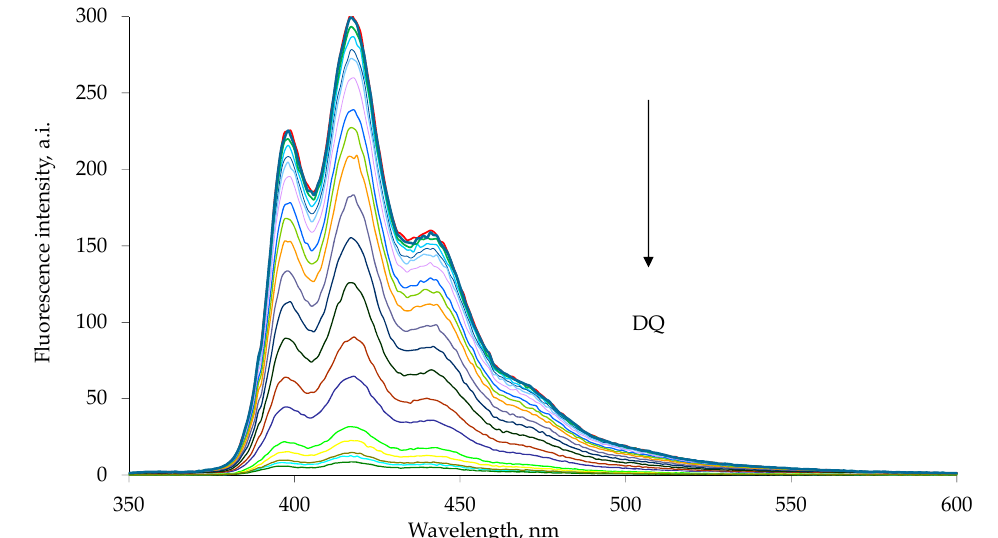
Figure 6. Fluorescence quenching of 1b host with increasing diquat concentration in chloroform– methanol 1:1 solution at 25 °C. The emission spectra were measured with excitation at 263 nm. Each spectrum is reported with different color line (Entry 1–20 Table 4).